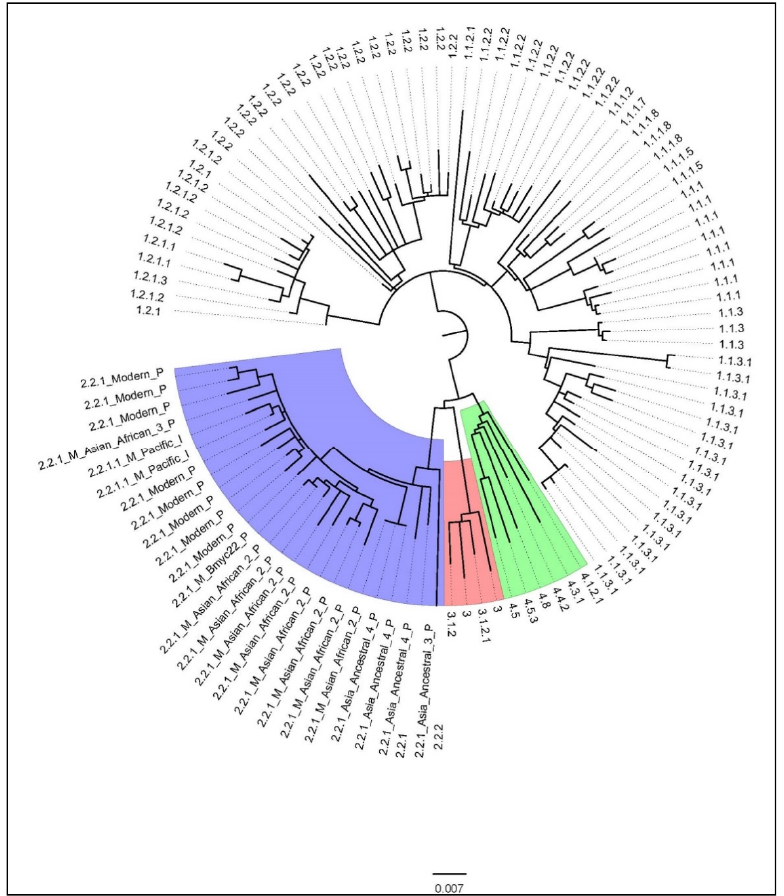
Figure 1. A phylogenetic tree of 109 Mycobacterium tuberculosis isolates from Kayin State, constructed by the maximum likelihood method . Table 2. Frequency Distribution of Major Lineages and Sublineages .